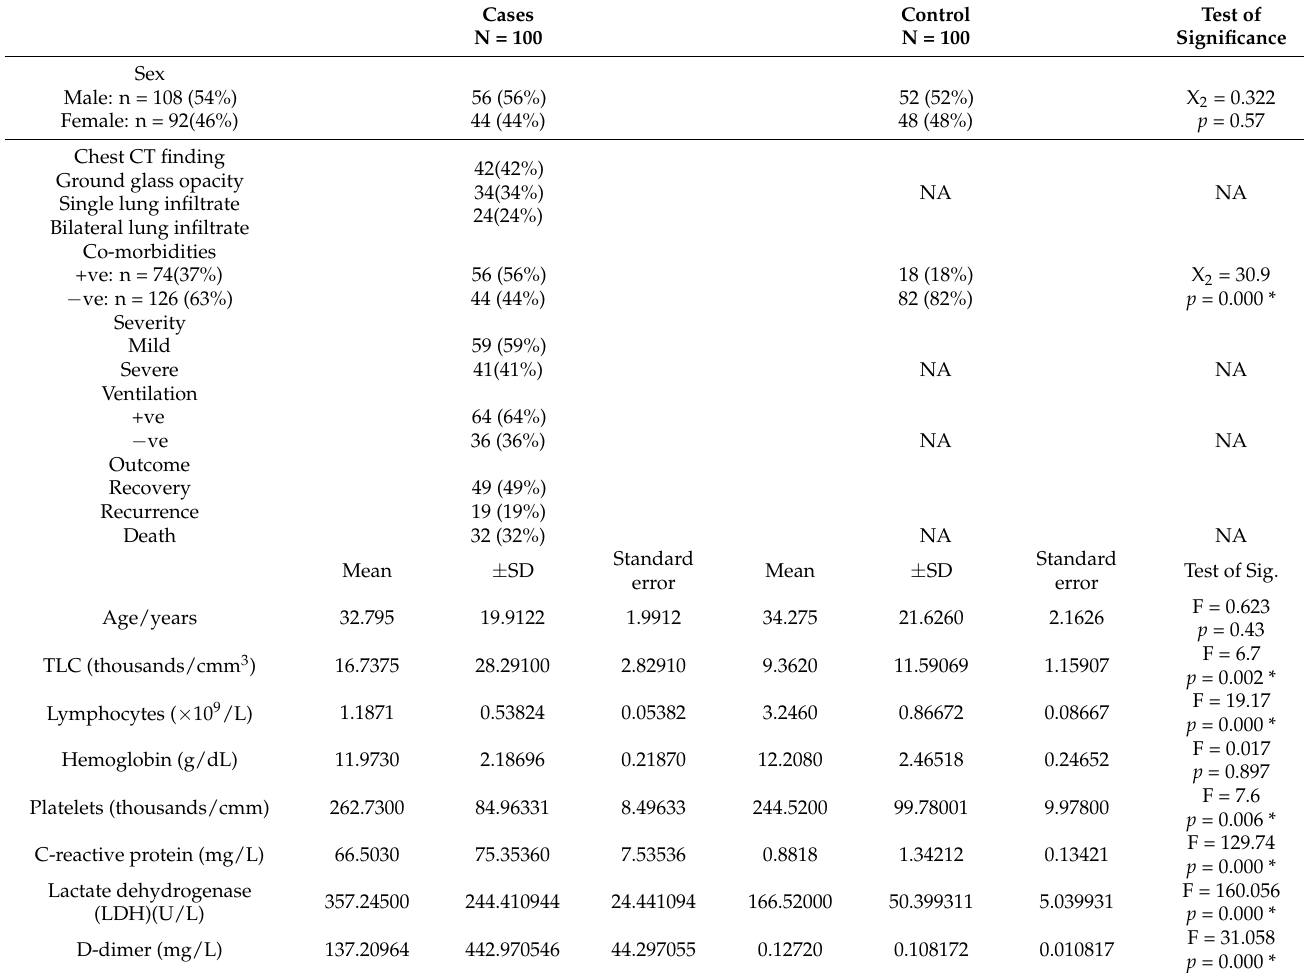
Table 1. The demographic, clinical and biochemical indices of the study groups.